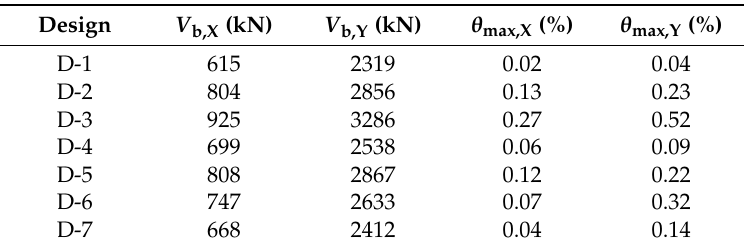
Figure 7. Inter-story drift profile for the X -direction ( a ) and Y -direction ( b ) under seismic loads.